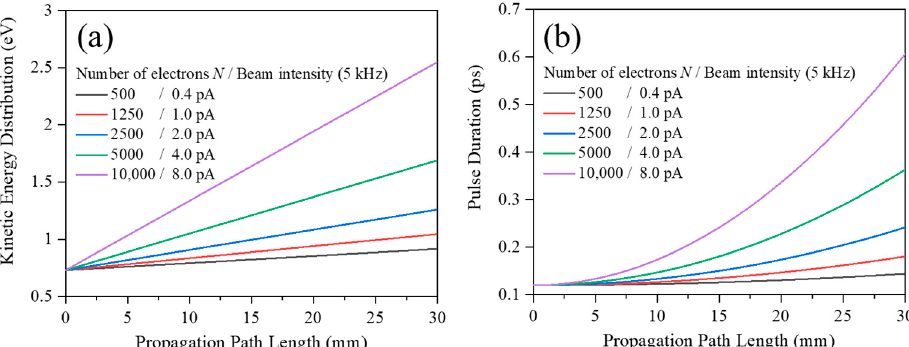
Figure 6. ( a ) Full width at the half maximum (FWHM) of the electron packet’s kinetic energy distribution (centered at 2.0 keV) and ( b ) FWHM of the electron packet’s pulse duration vs. propagation path length and their dependence on the number of electrons, calculated by using the mean field model. See text for details.